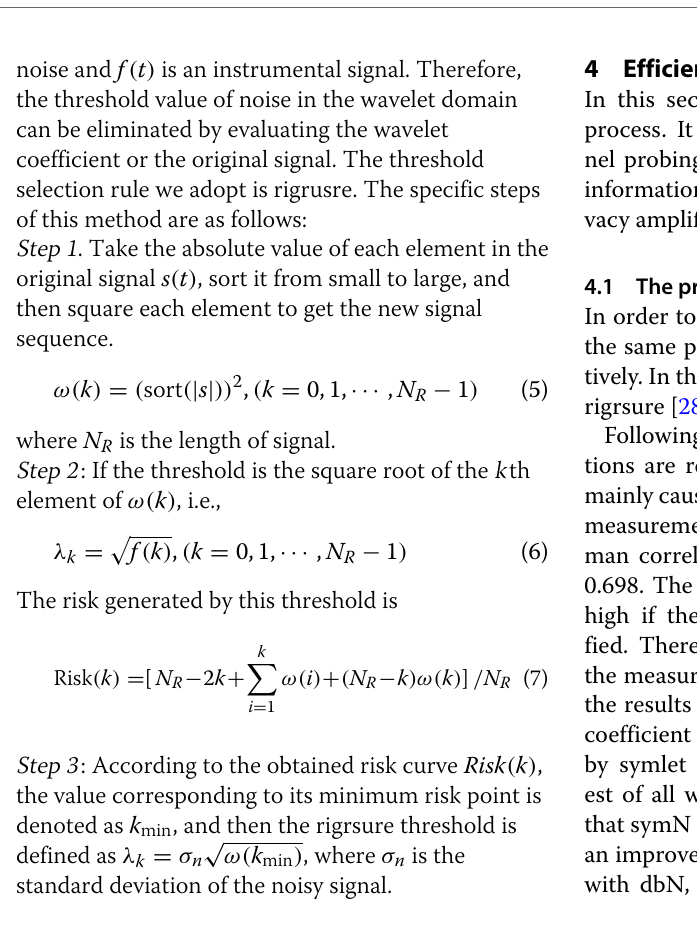
Fig. 2 Key generation process